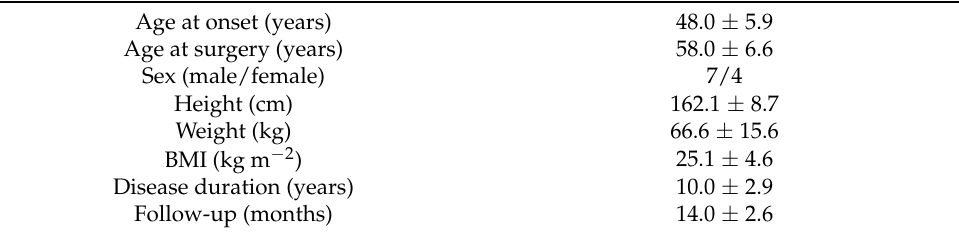
Table 1. Subject characteristics of Parkinson’s disease patients undergoing deep brain stimulation.